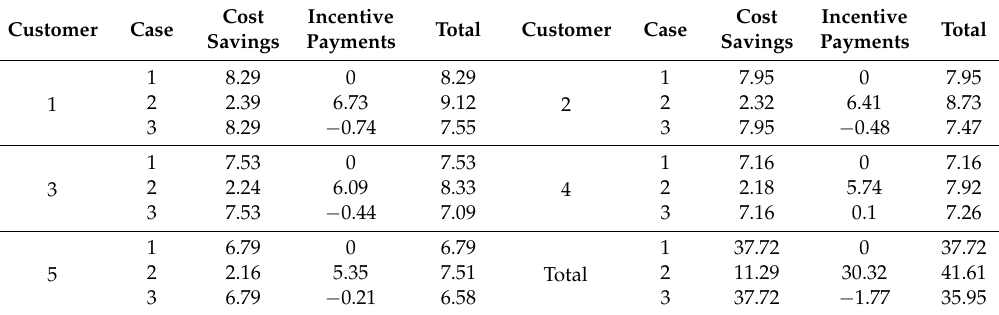
Table A2. Profit of customers on Day 2 (unit: $).